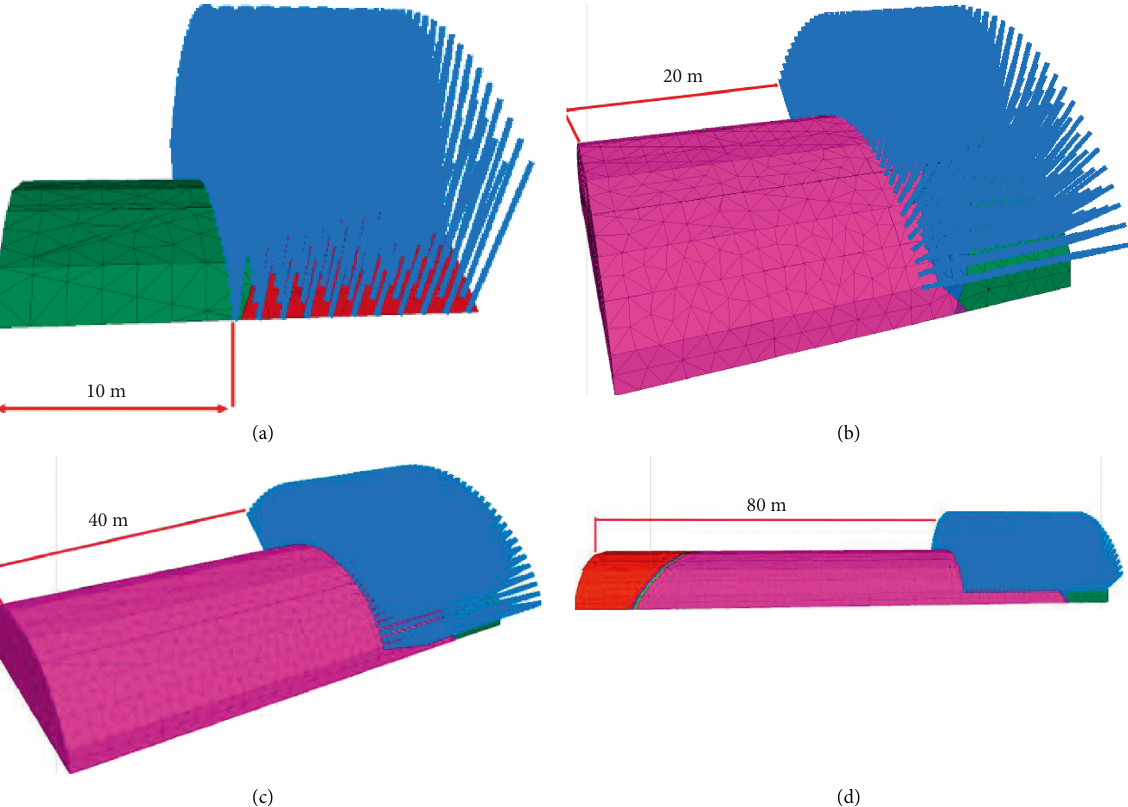
Figure 13: Schematic diagram of different distances of prestressed bolt lag working face. (a) Prestressed bolt lags 10 m behind working face. (b) Prestressed bolt lags 20 m behind working face. (c) Prestressed bolt lags 40 m behind working face. (d) Prestressed bolt lags 80 m behind working